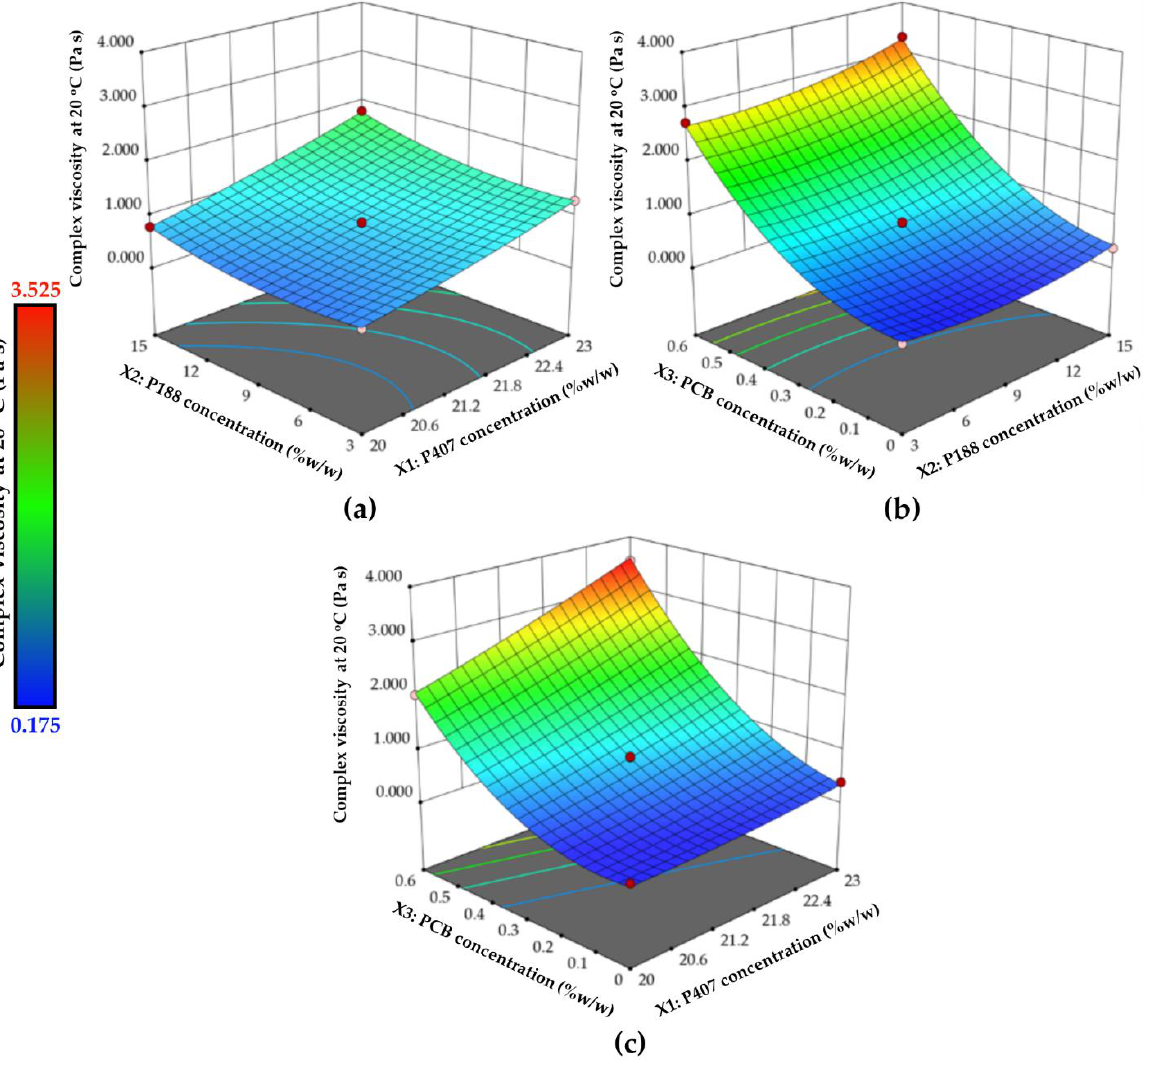
Figure 3. The 3D-response surface plots showing the impact of different independent variables on the complex viscosity at 20 °C; ( a ) effect of X 1 and X 2 at the mid-level of X 3 , ( b ) effect of X 2 and X 3 at the mid-level of X 1 , and ( c ) effect of X 1 and X 3 at the mid-level of X 2 .